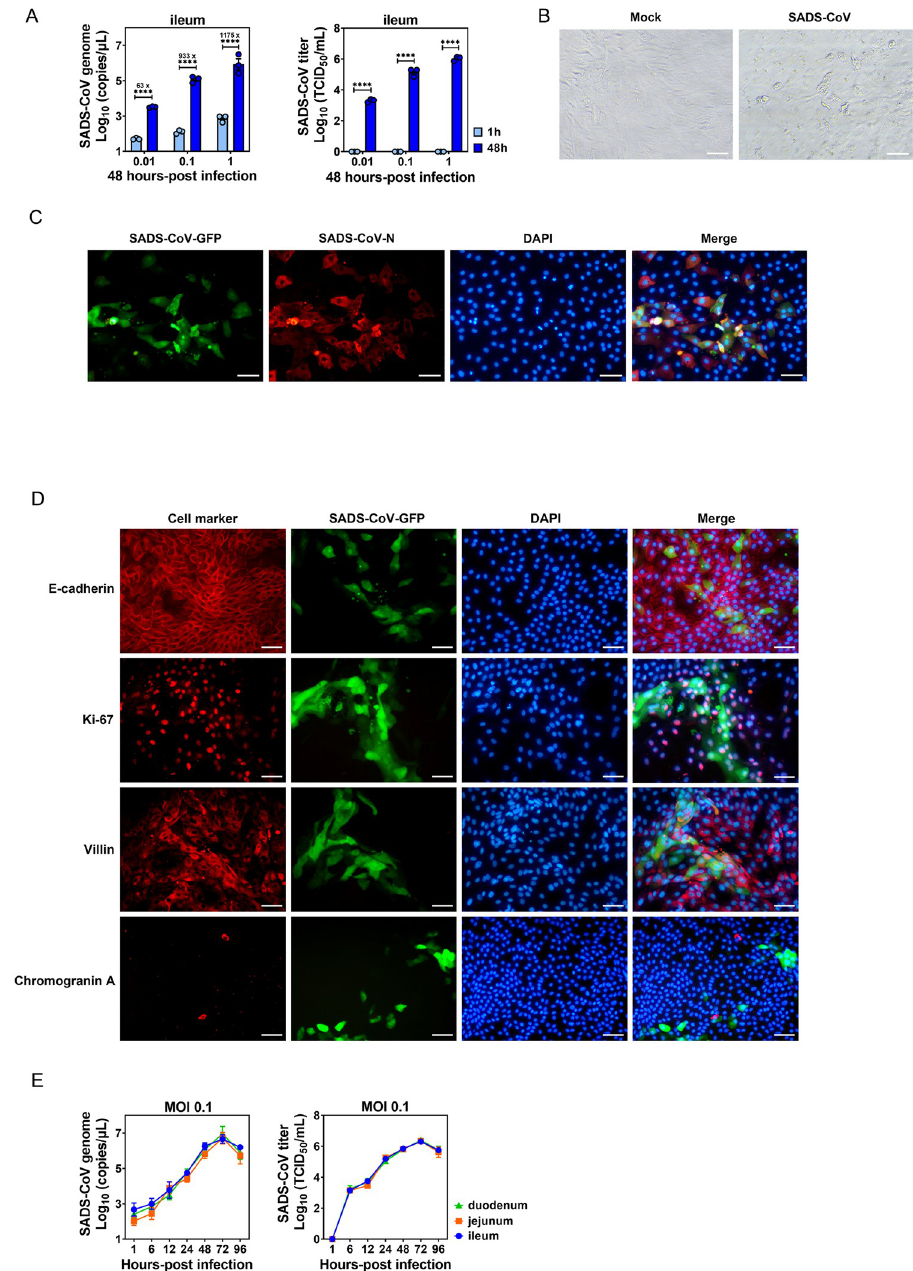
Fig 2. Porcine intestinal enteroid (PIE) cultures support SADS-CoV replication. (A) Ileal PIE monolayers were incubated with medium or SADS-CoV-GFP at the indicated MOIs on a rotary shaker for 1 h at 37˚C. The incubated monolayers were washed three times with PBS and harvested at 1 or 48 hpi. Supernatant RNA was extracted and the number of SADS-CoV-GFP genome copies was determined by RT-qPCR and viral titer was determined by a standard TCID 50 assay. (B) Cytopathic effect (CPE) was observed in ileal PIEs infected with SADS-CoV at 48 hpi (scale bar, 50 μ m). (C) Immunofluorescence assay (IFA) was performed using rabbit anti-SADS-CoV-N polyclonal antibody and Alexa Fluor 594-conjugated anti-rabbit IgG as secondary antibody, and nuclei (blue) were visualized by DAPI (scale bar, 50 μ m). (D) Colocalization of SADS-CoV-GFP and cellular markers (red) including E-cadherin (epithelial tight junction), Ki-67 (proliferating cells), villin (enterocytes) and chromogranin A (enteroendocrine cells), and nuclei (blue) stained by DAPI (scale bar, 50 μ m). (E) Duodenal, jejunal and ileal PIE monolayers were incubated with SADS-CoV-GFP at MOI = 0.1 and the SADS-CoV-GFP replication kinetic was determined by RT-qPCR or TCID 50 . Data are from three independent experiments. P values were determined by unpaired two-tailed Student’s t test. � : p < .05; �� : p < .01; ��� : p < .001; ���� : p < .0001; ns, not significant.